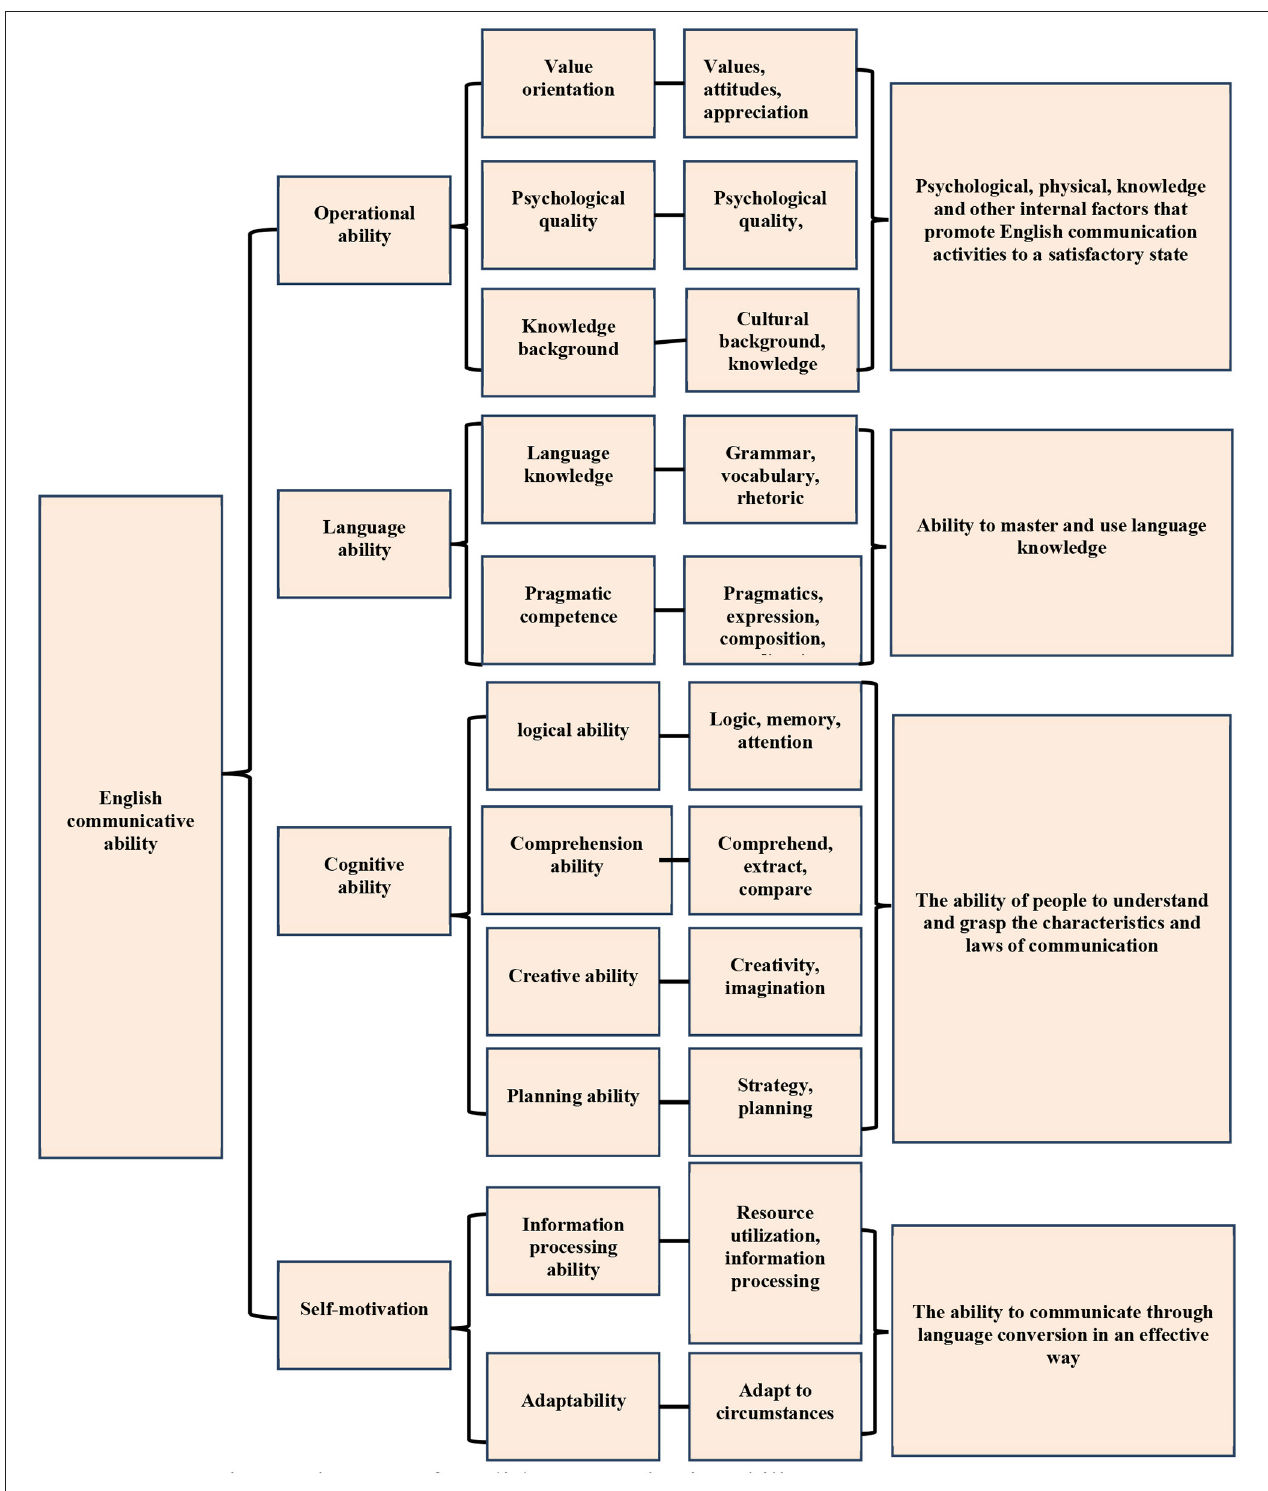
FIGURE 3 | Constituent elements of English communication